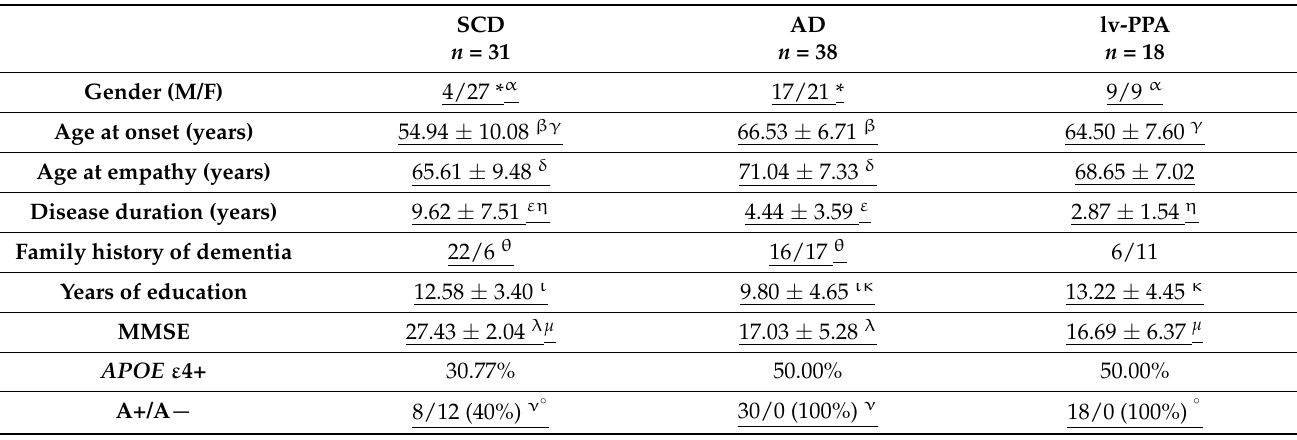
Table 1. Demographic features in Alzheimer’s disease (AD) and logopenic variant primary progres- sive aphasia (lv-PPA)